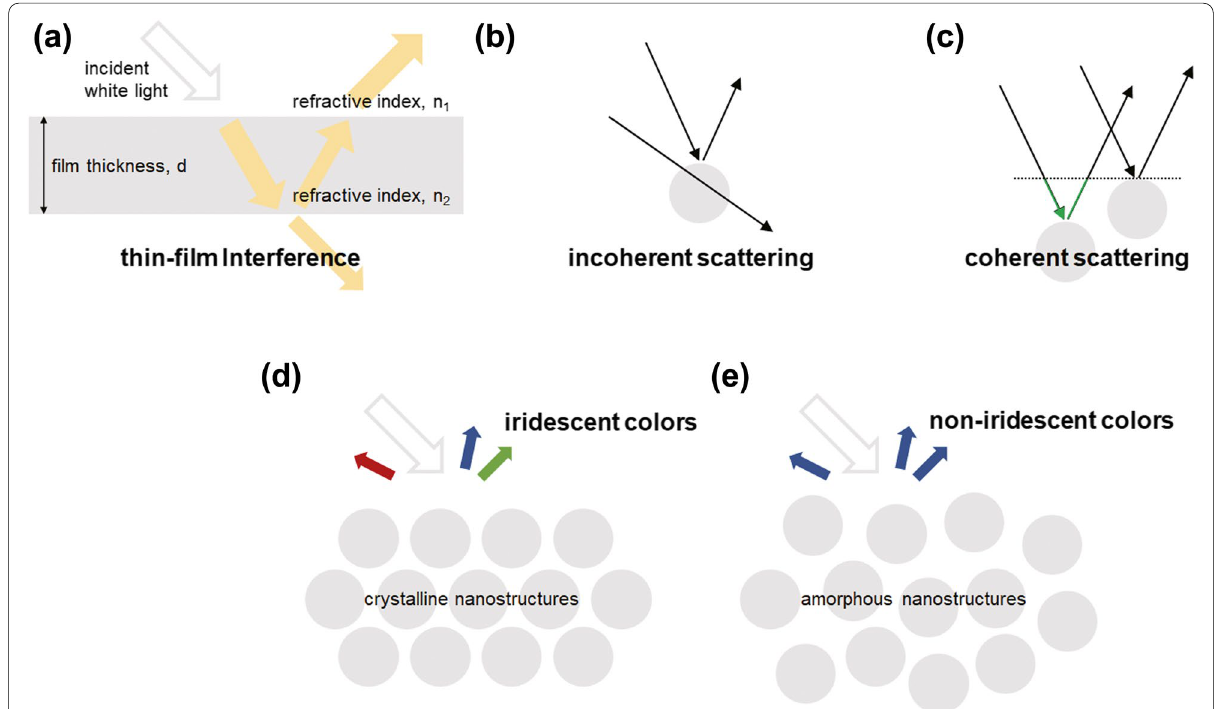
Fig. 1 ( a ‑ c ) Basic physical mechanisms of structural coloration in birds. Structural colors appeared in barbs or barbules are based on ( a ) Thin‑film interference, ( b ) Incoherent scattering, ( c ) Coherent scattering, ( d ‑ e ) Representative melanin‑based photonic nanostructures, ( d )